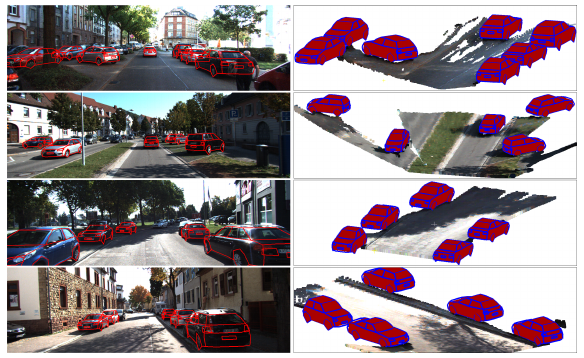
Figure 6. Qualitative results. Left: Backprojected model wireframes. Right: 3D view on the reconstructed scene; estimated ground plane and the 3D vehicle models are